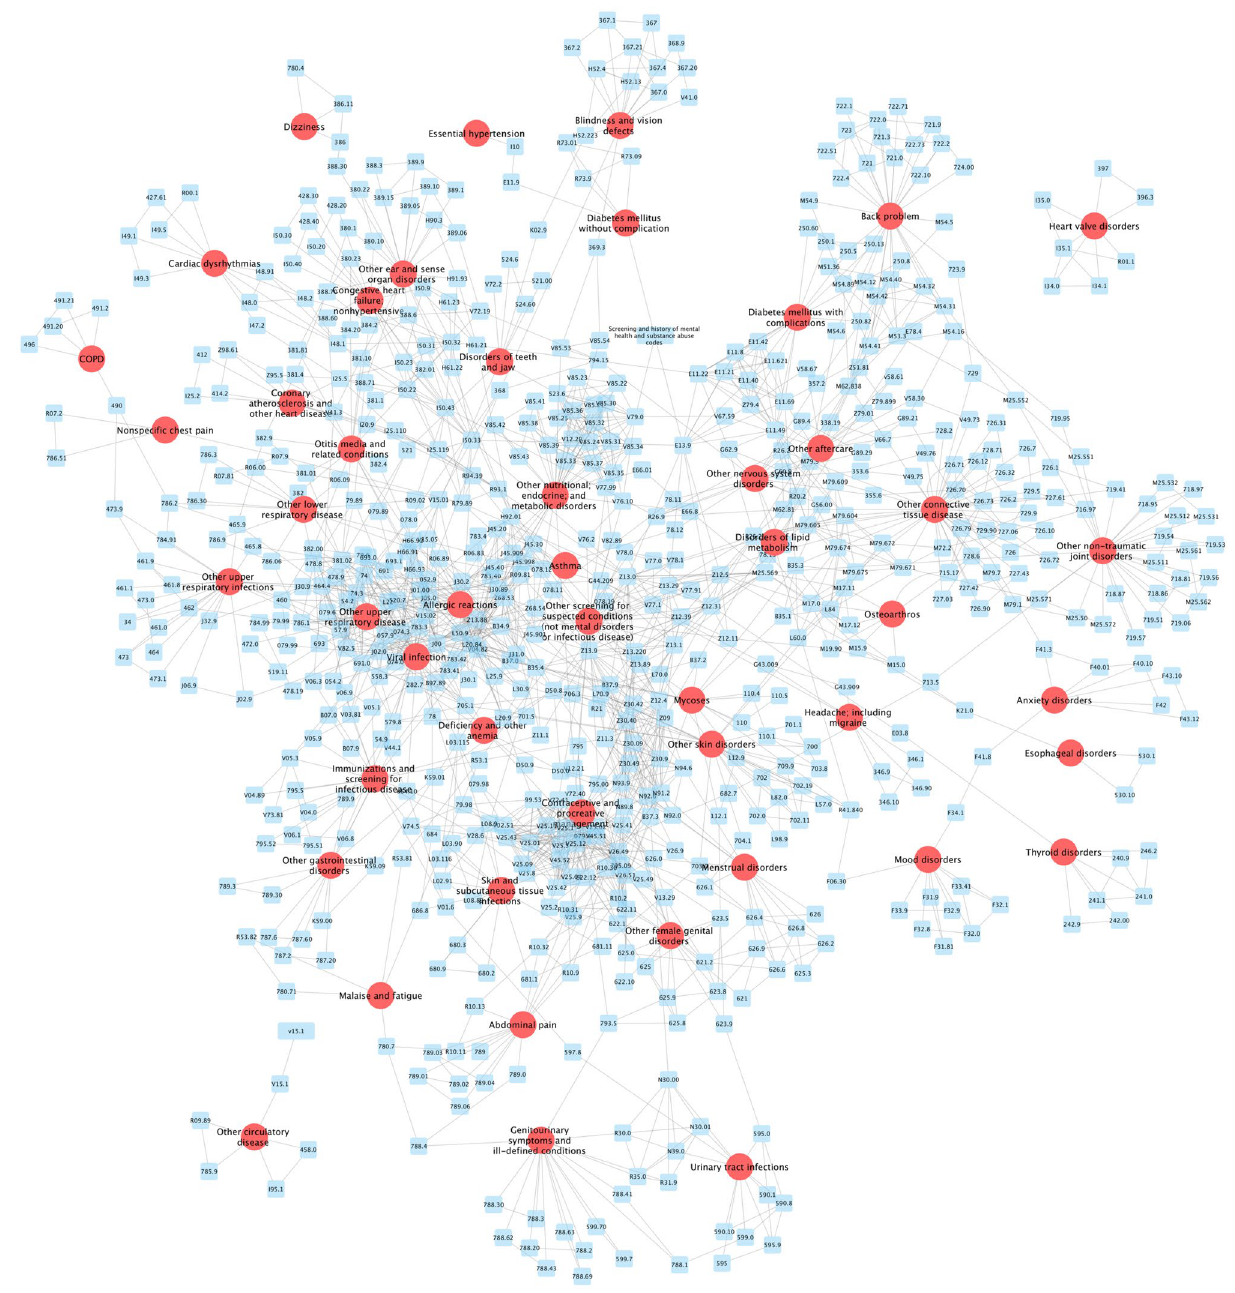
(https:// cytos cape.